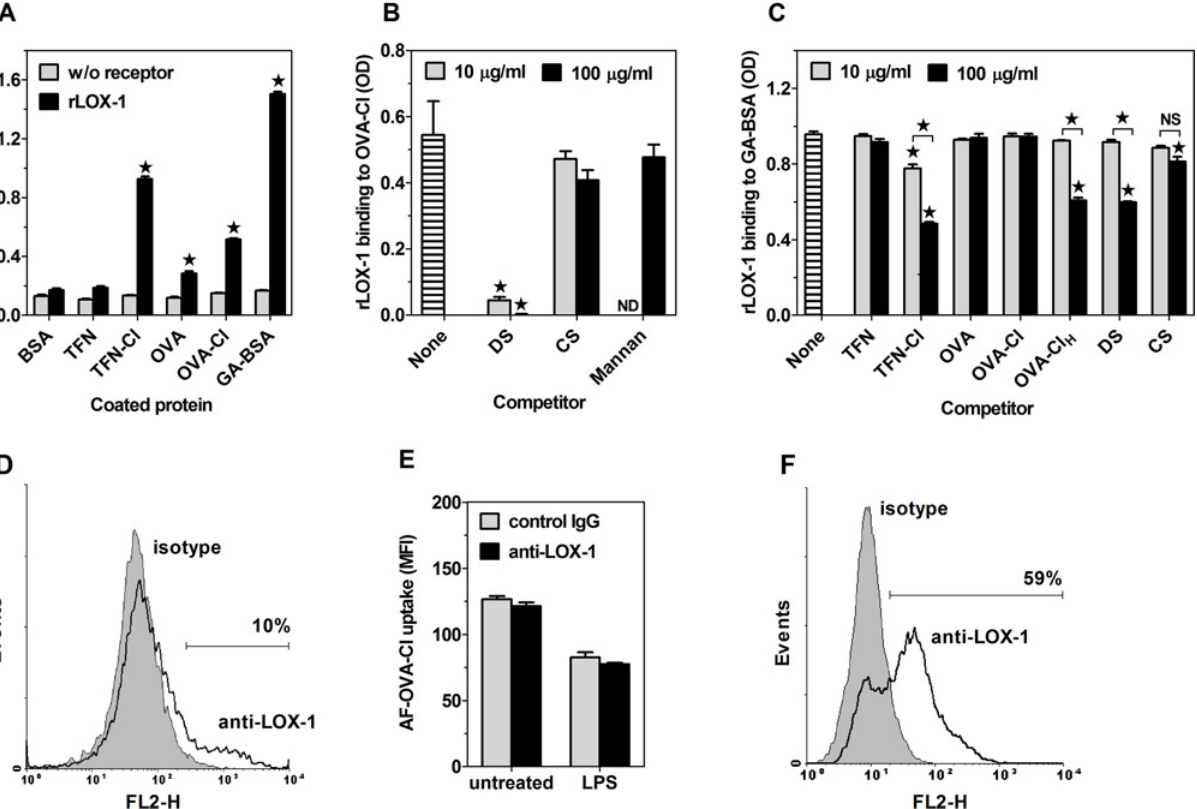
Fig 8. LOX-1 is capable of binding HOCl-modified proteins, but does not contribute to OVA-Cl uptake by BM-DC. ( A ) Binding of rLOX-1 to plate- adsorbed proteins. ( B , C ) Effects of 10 or 100 μ g/ml of indicated, soluble ligands on rLOX-1 binding to plate-adsorbed OVA-Cl (B) or GA-BSA (C). ( D ) Binding of PE-conjugated anti-mouse LOX-1 mAb and control rat IgG2a to CBA BM-DC, determined by flow cytometry. ( E ) The effect of blocking goat anti-mouse LOX-1 polyclonal Ab, relative to normal goat IgG, on AF-OVA-Cl uptake by untreated and LPS-pre-treated CBA BM-DC. ( F ) LOX-1 expression on LPS-pre- treated CBA BM-DC. Results of single experiments are shown, repeated at least twice with similar results. The data were analysed by the Student ’ s t-test (A, E) or by ANOVA, followed by the Tukey-Kramer post-test (B, C). * , p < 0.05; NS, non-significant.